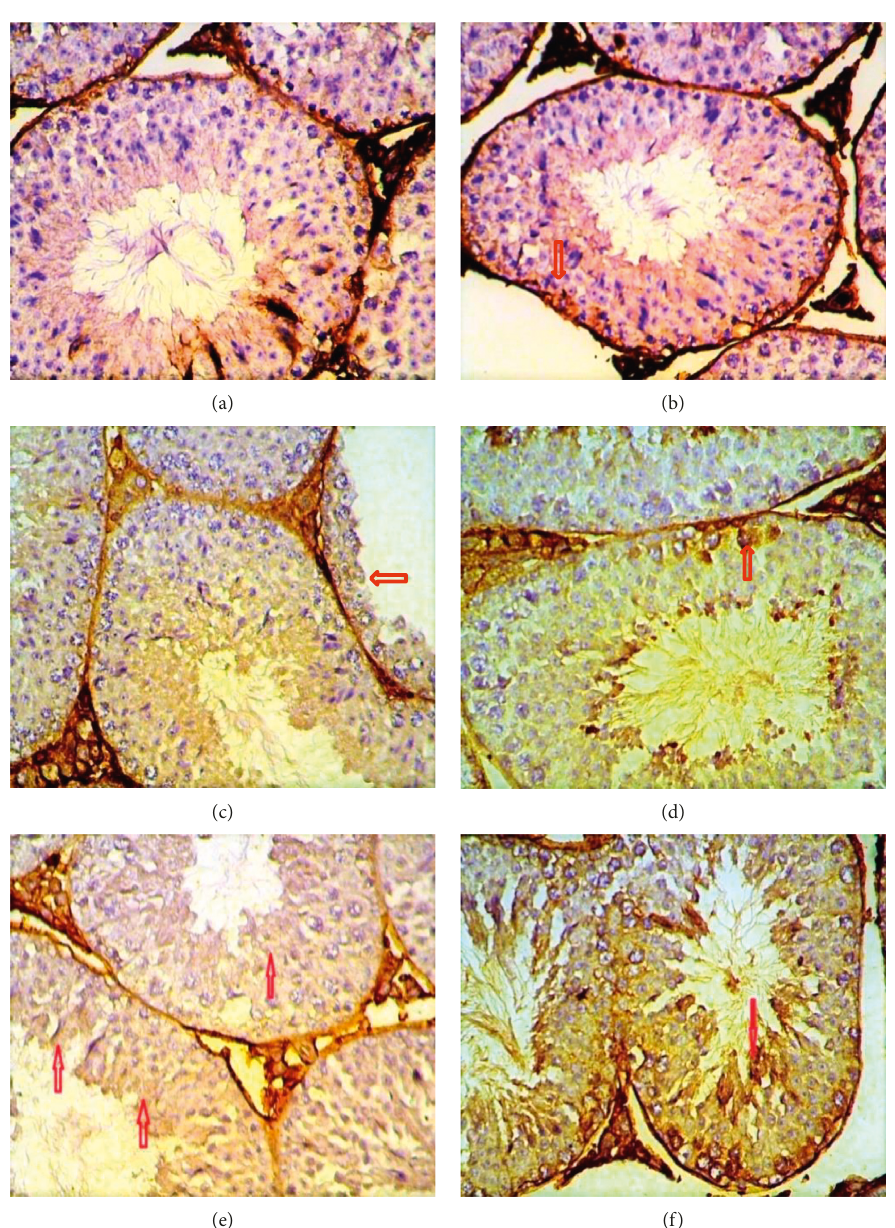
Figure 8: Immunohistochemical staining method detection of Ki67 using a section of mice testis tissue treated with CuSO 25 and 35mg/kg; weak positive expression: (a, b, d) CuO.T1; (e) CuSO 4 .T2; (f) CuO.T2; (c) CuSO 4 .T1